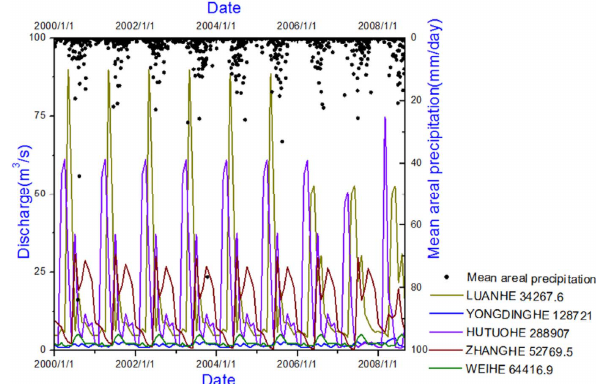
1041 Fig.9. Annual mean ET from the model simulation (bold blue line) and the ET-watch (bold 1042 Fig. 9. Annual mean ET from the model simulation (bold blue line) red line). The lighter lines represent +/- one standard deviation from the mean values for 1043 and the ETWatch (bold red line). The lighter lines represent ± one each of the eight land cover classes considered. 1044 standard deviation from the mean values for each of the eight land cover classes considered.